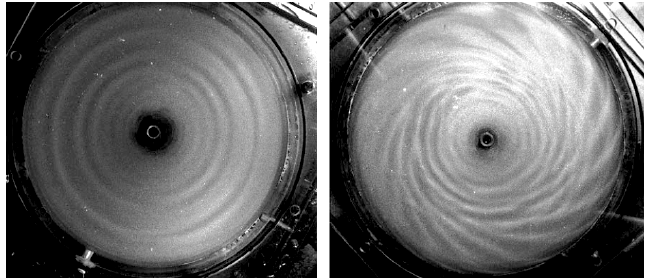
Figure 6. Experimental visualisation of instabilities